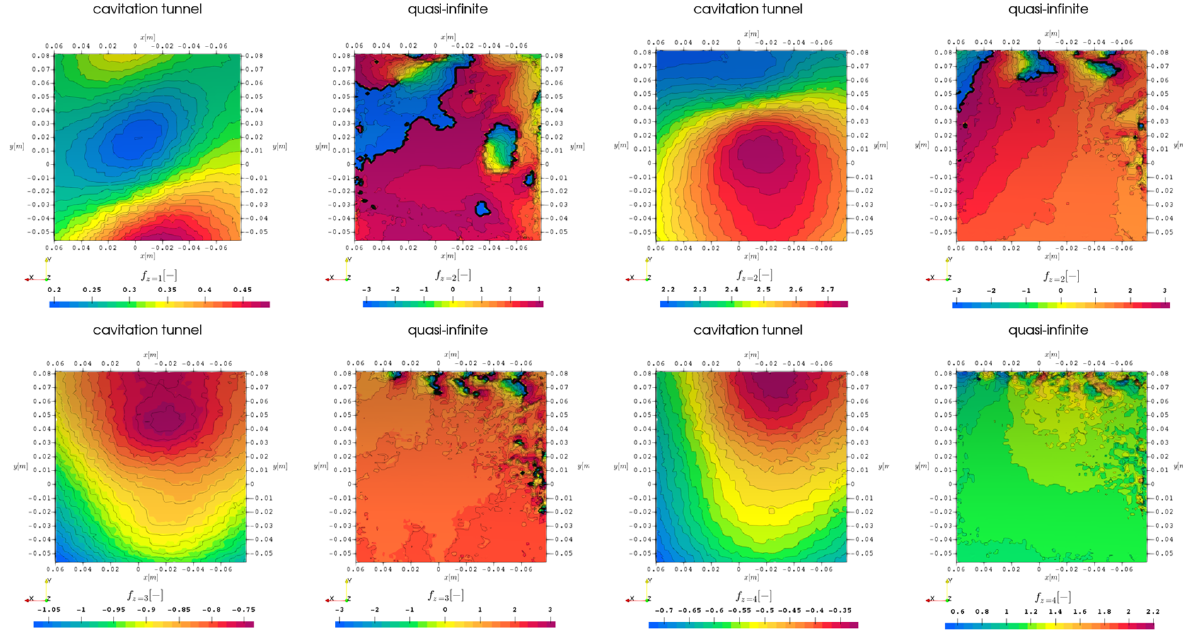
Figure 9. Phase information on hull at the first 4 harmonic propeller blade harmonic frequencies, comparison of domain extent, LES with cavitation.